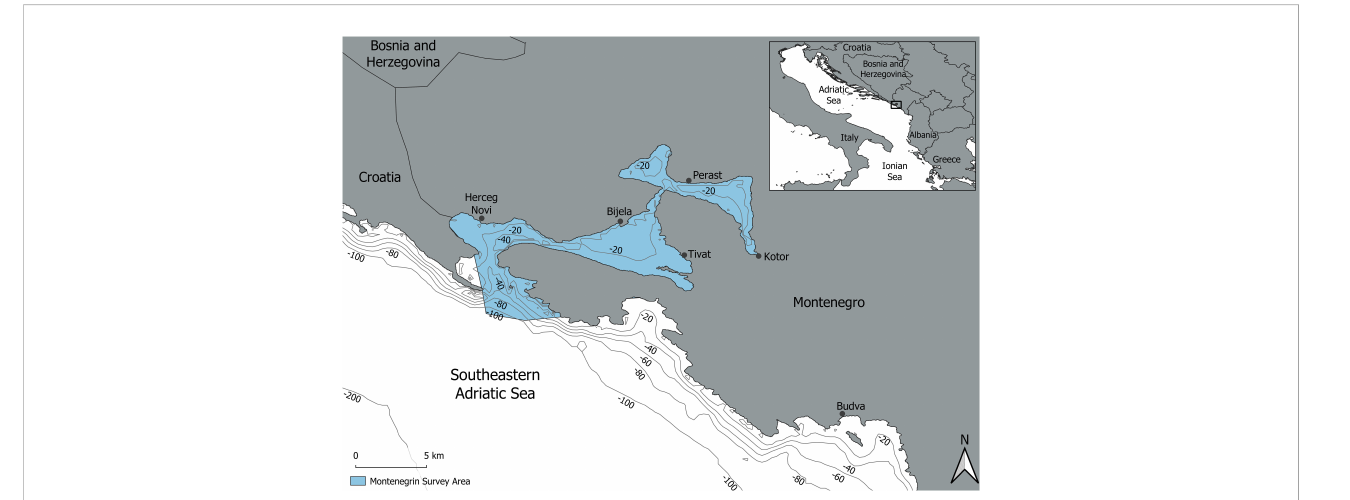
FIGURE 2 Map of the study location in the Boka Bay, South Adriatic Sea, Central-Eastern Mediterranean